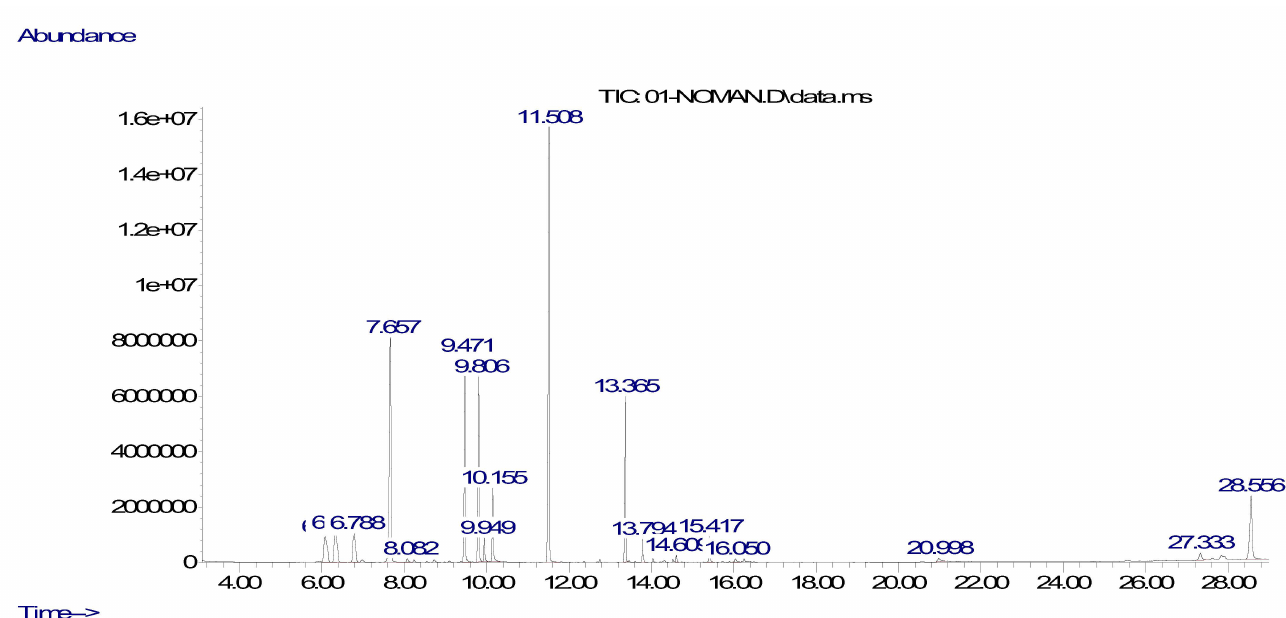
Figure 1. GC-MS chromatogram of R. officinalis